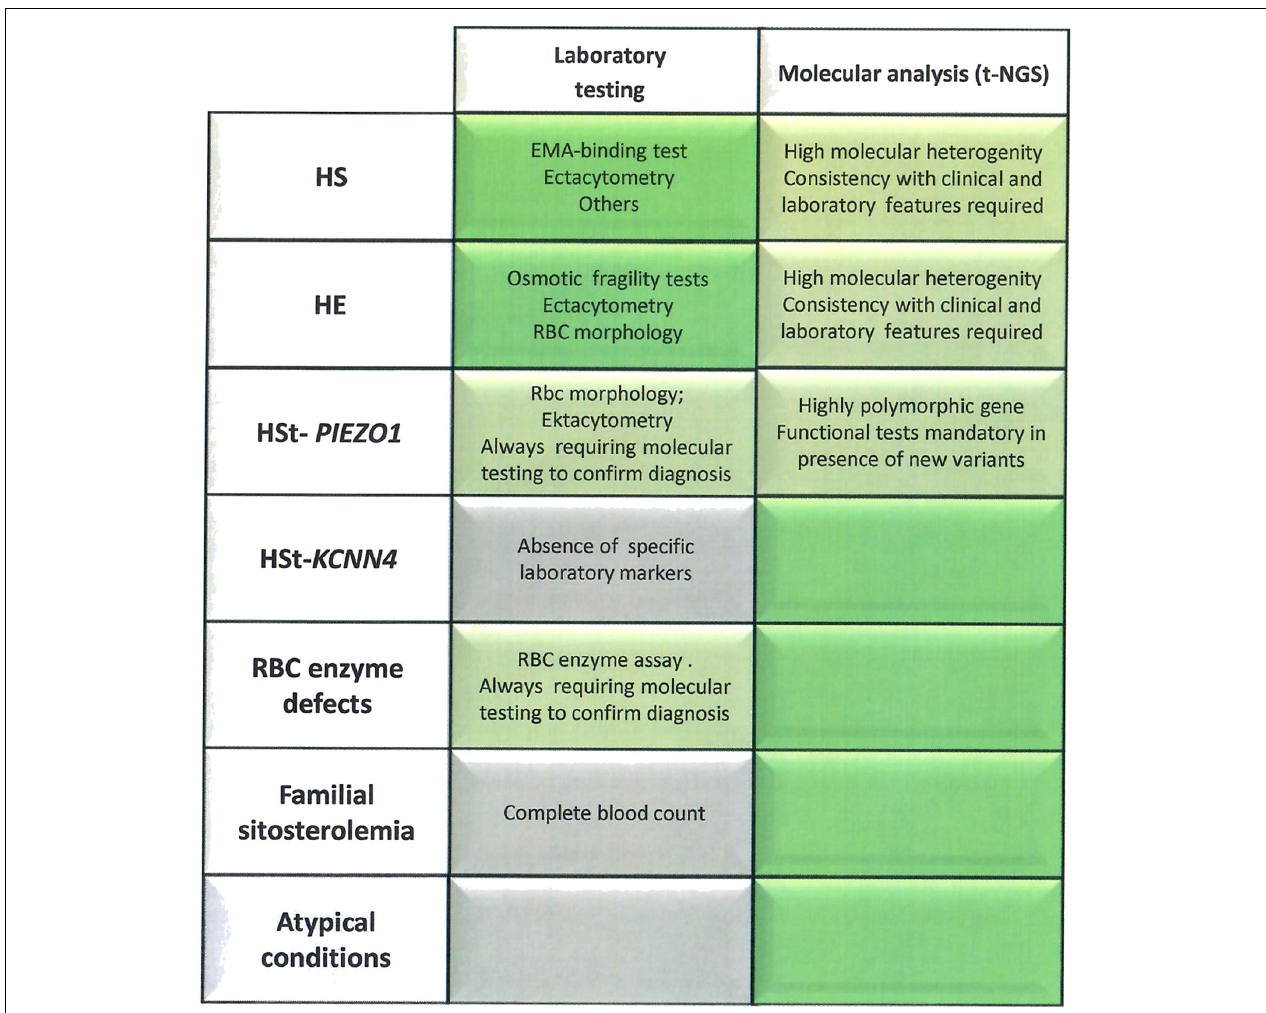
FIGURE 3 | Advandages and limitations of laboratory approach vs. t-NGS technologies in congenital hemolytic anemias. The laboratory tests/parameters specifically useful for diagnosis of different diseases are reported. Brilliant green, exhaustive diagnostic approach; Green, requiring other approaches to confirm the diagnosis; gray, insufficient laboratory markers to reach the